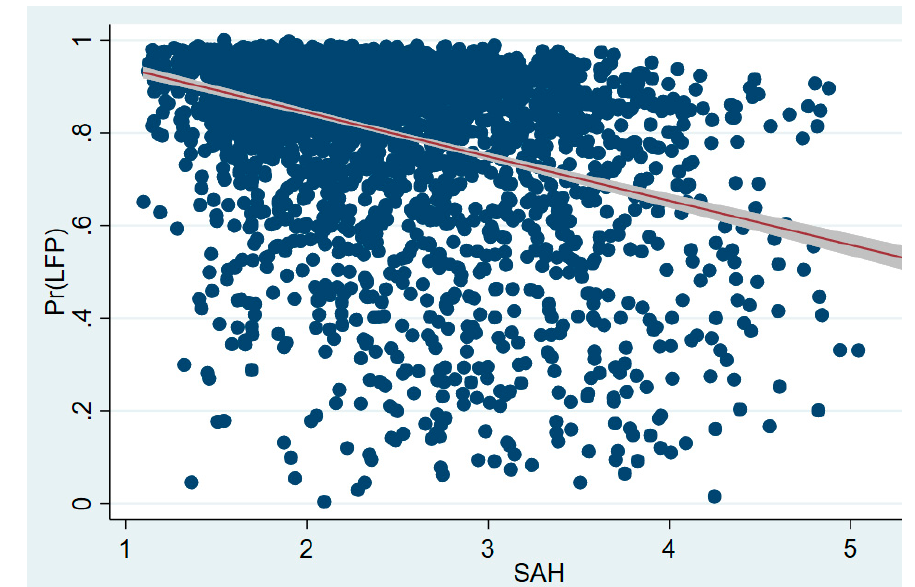
Figure 1. Health and LFP of rural elderly men.